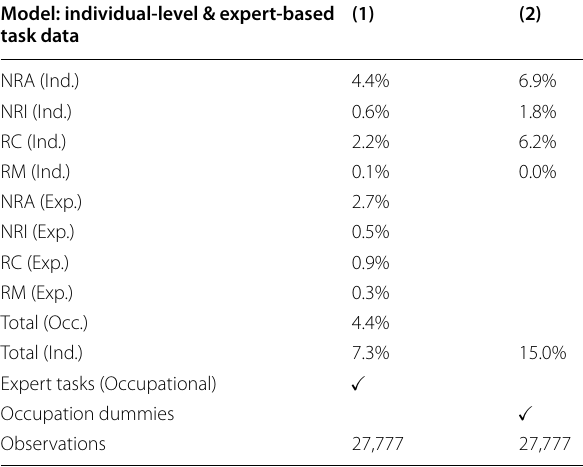
Table 15 Robustness tests on unique variation explained by task measures: narrow definition of